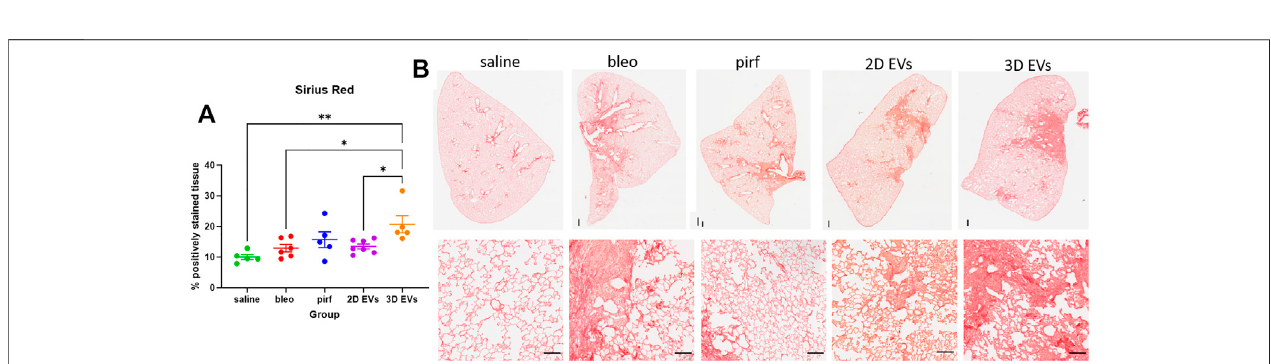
FIGURE 6 | Histological images of lungs at D28 stained with Sirius Red stain and quanti fi cation of collagen deposition. (A) Percentage of positively stained tissue. (B) Representative images of whole lung tissues (upper panel) and lung alveolar area (lower panel). Data represent mean ± SEM, n = 5-8 per experimental group; each symbol represents 1 animal, one-way ANOVA followed by Tukey ’ s post hoc test for multiple comparisons, * p < 0.05, ** p < 0.01. Upper panel scale bar is 500 µm and bottom panel scale bar is 100 µm.